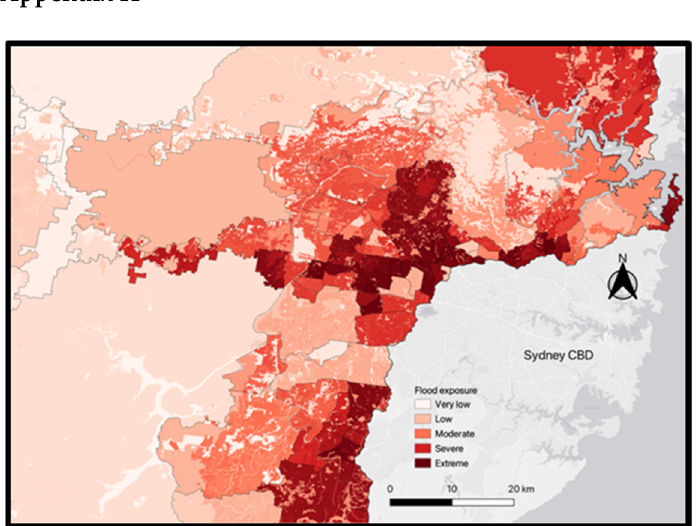
Figure A2. Map of FEI of smaller SA2s on or near the floodplain of the HNC based on three indicators: population density, land use type, and critical infrastructure density (presented at 50 m resolution within SA2 boundaries via QGIS 3.24).